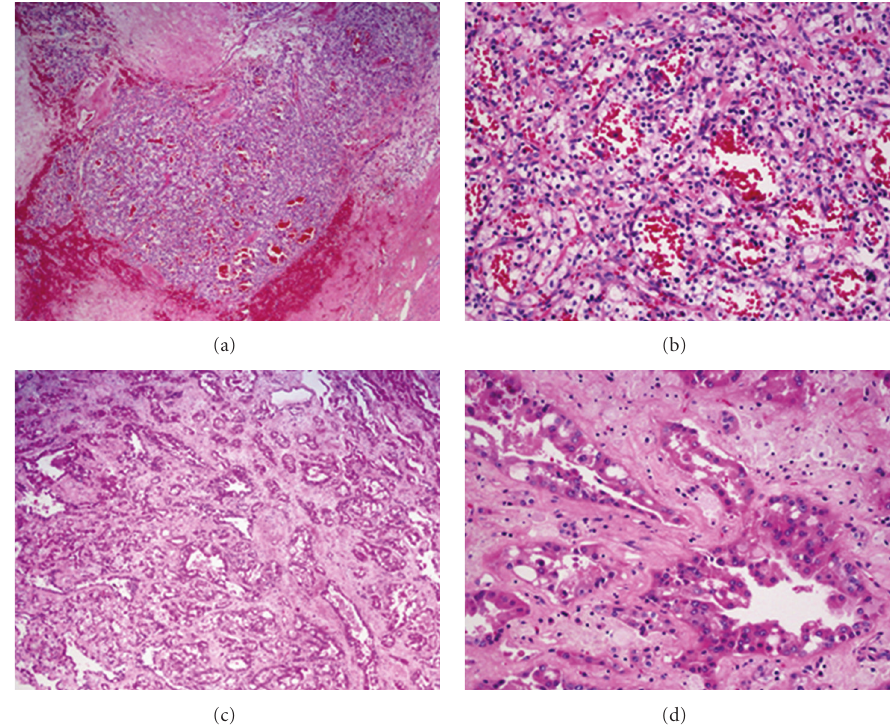
Figure 4: Histological findings (H&E staining) (a) The posterior tumor consisted of clear renal cell carcinoma in alveolar pattern ( × 40). (b) The tumor cells were round or polygonal with abundant cytoplasm ( × 200). (c) The lateral tumor was composed solely of eosinophilic cells in tubulocystic pattern ( × 40). (d) The tumor cells had small nuclei with granular cytoplasm ( ×